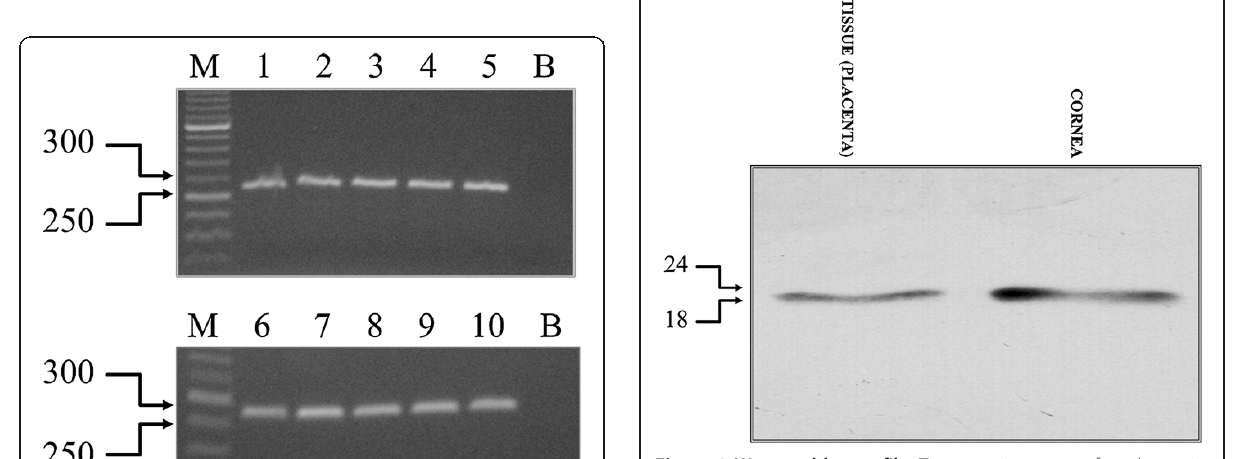
Figure 3 Western blot profile. Twenty micrograms of total protein were loaded onto 12% polyacrylamide gel, fractionated, blotted onto nitrocellulose and exposed overnight to an anti-TCTP antibody. The position of MW markers, in kDa, is indicated. Control tissue was